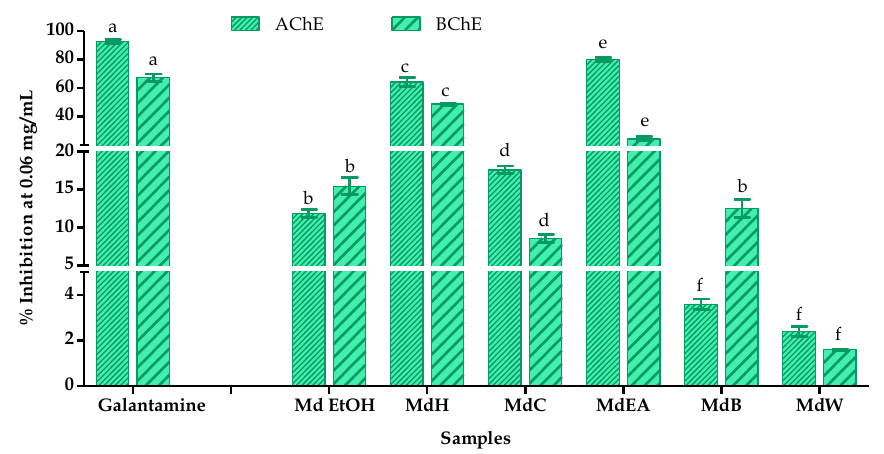
Figure 6. AChE and BChE inhibition in % by M. diffusa samples and the positive control galantamine expressed as percentage of inhibition at 0.06 mg/mL. Samples are crude ethanol extract (Md EtOH), n -hexane fraction (MdH), chloroform fraction (MdC), ethyl acetate fraction (MdEA), n -butanol fraction (MdB) and water fraction (MdW). Data are expressed as mean ± standard deviation from three experiments. In each test, the values with the same letter (a, b, c, d, e, f) are not significant different at the p > 0.05 level, 95% confidence limit, according to one-way analysis of variance (ANOVA).